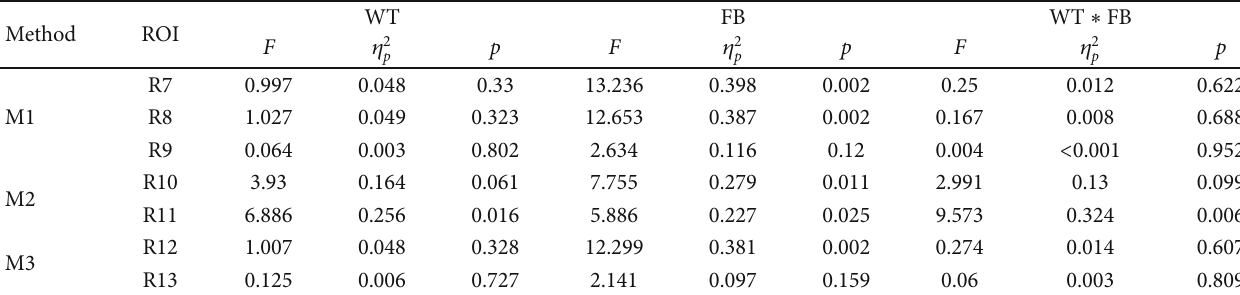
Table 2: The statistical results of P3-delta oscillation for the conventional time-frequency analysis ( “ M1 ” ), the proposed approach ( “ M2 ” ), and TFA-PCA( “ M3 ”